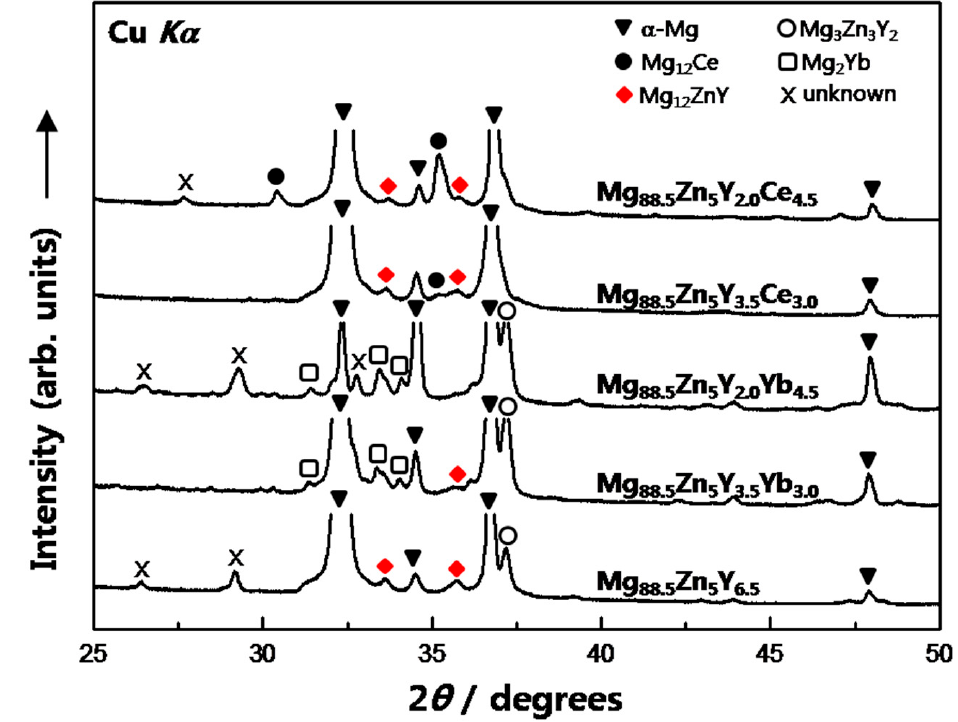
Figure 1. XRD patterns of the Mg-Zn-Y-Ce and Mg-Zn-Y-Yb alloys. Figures 2 and 3 show the SEM micrographs of the as-cast Mg 88.5 Zn 5 Y 6.5-X RE X alloys. The light and dark gray phases denote the LPSO phases and intermetallic compounds (marked by an arrow), respectively. A coarse dendritic structure was formed by the continuous network of the LPSO phases and intermetallic compounds. The volume fraction of the LPSO phases decreased significantly with the increase in the Yb and Ce content. The LPSO phases were not detected in Mg 88.5 Zn 5 Y 2.0 Yb 4.5 , and this result was consistent with the XRD analysis. The XRD data indicated that the Mg 3 Zn 3 Y 2 phases constituted the compounds in Mg 88.5 Zn 5 Y 6.5 . The Mg 2 Yb phases were the primary constituents of the compounds in the Mg-Zn-Y-Yb alloys, while the Mg 3 Zn 3 Y 2 and Mg 12 Ce phases were the primarily constituents of the compounds in the Mg-Zn-Y-Ce